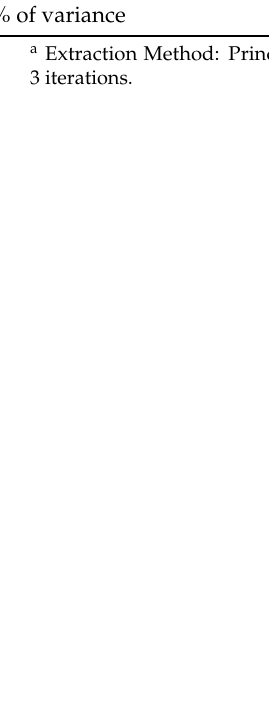
Table 3. Table of associations: quarantined locality and